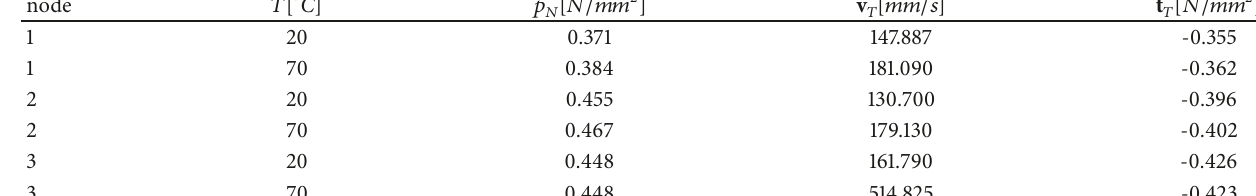
Table 5: Representative values of tangential stresses obtained in the FE tire simulation with corresponding 𝑝 𝑁 , k 𝑇 , and 𝑇 values. node